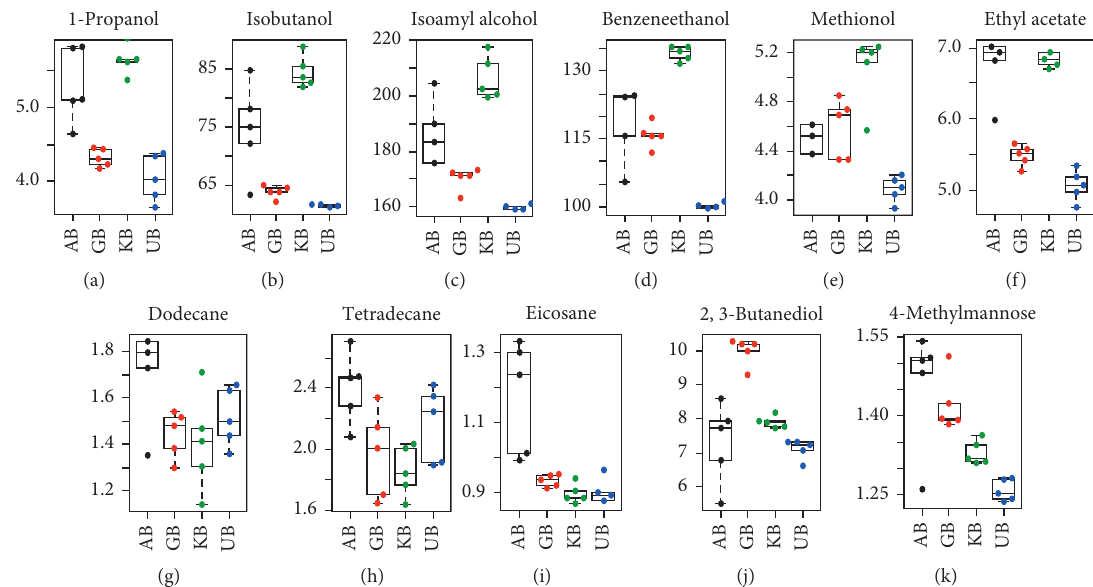
Figure 4: Box plot of volatile compounds affecting discrimination of beer samples. GB, UB, KB, and AB represent wheat beers made of grist containing 50% of wheat malt from German, USA, and Korean wheat variety ( Keumkang and Anzunbaengi ),